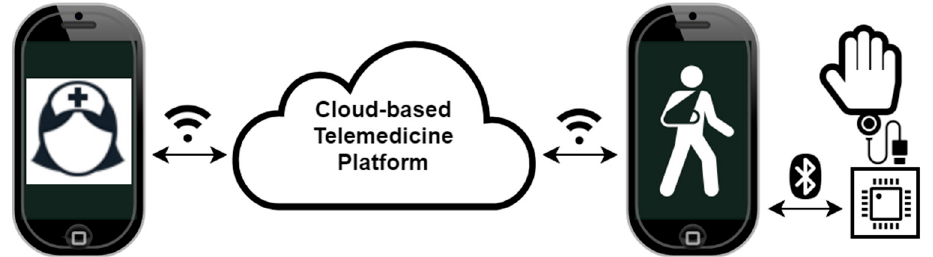
Figure 13. Cloud-based platform in support of remotely supervised therapy.